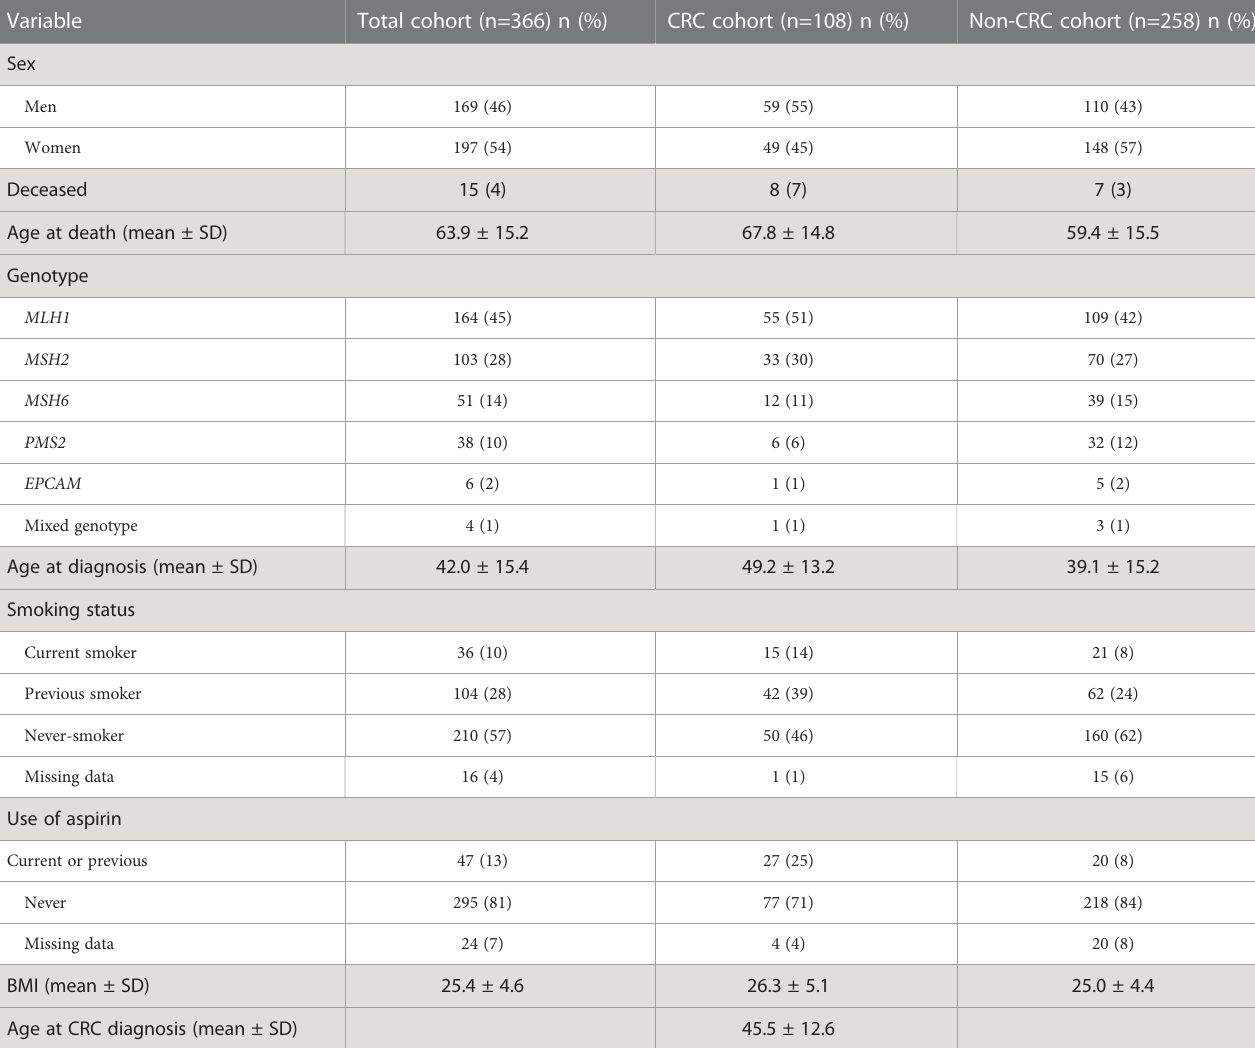
TABLE 1 Patient characteristics in total and separated by CRC